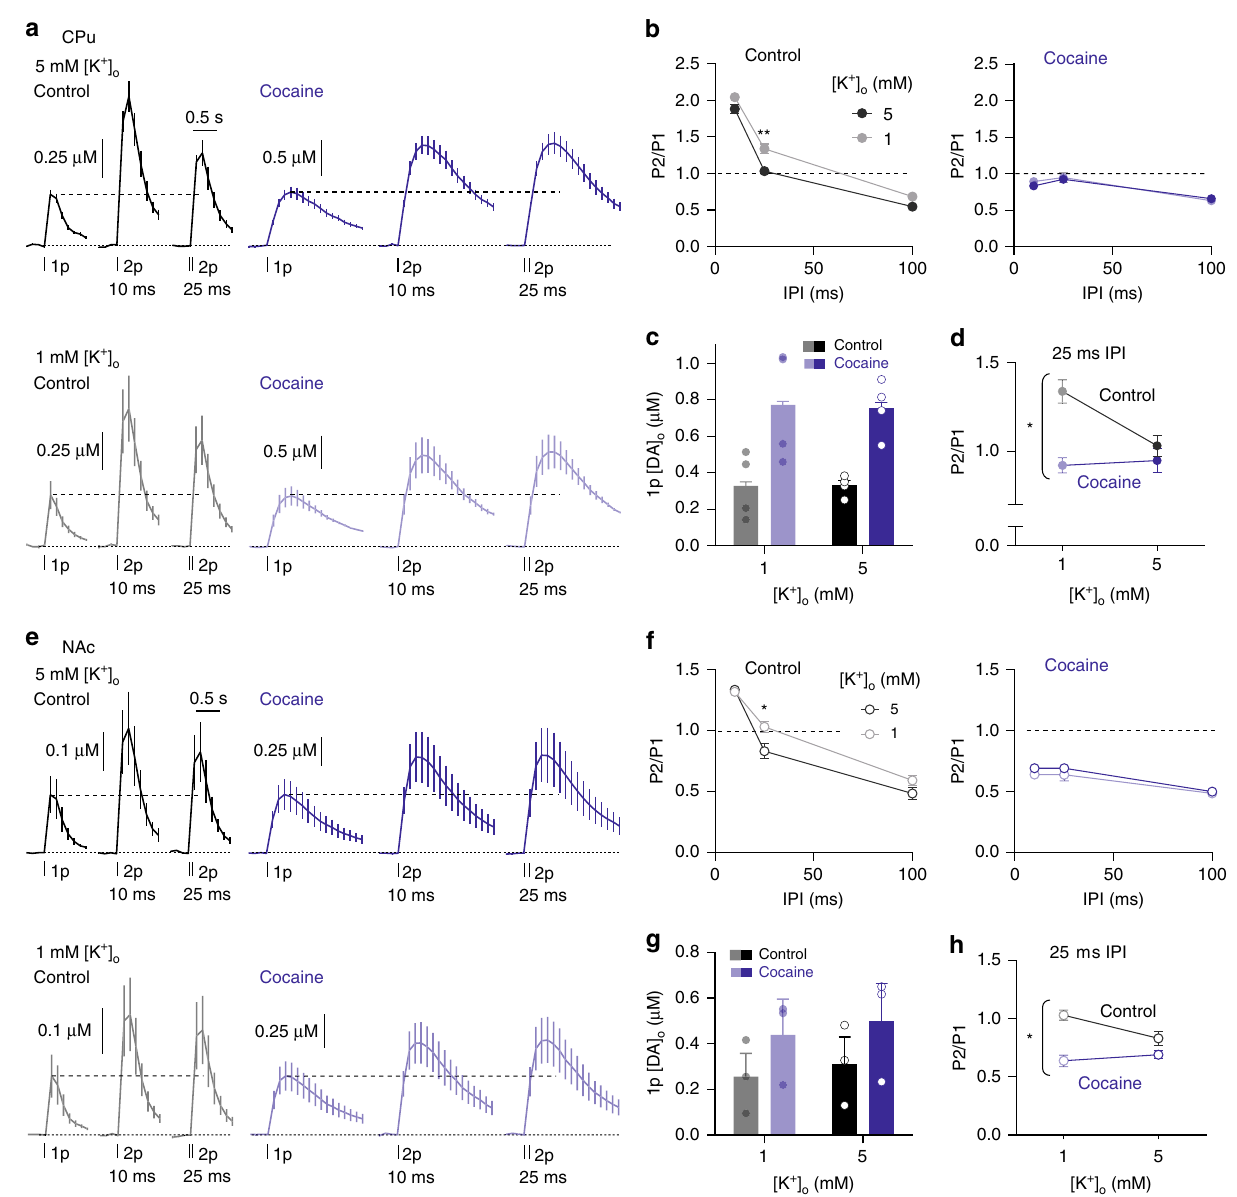
Fig. 8 DATs and [K + ] o gate short-term plasticity through overlapping mechanisms. a , e Mean pro fi les of [DA] o transients elicited by single or paired electrical pulses in control conditions or cocaine in 5 mM [K + ] o (upper) and 1 mM [K + ] o (lower) in CPu ( a , n = 4) and in NAc ( e , n = 3). b , f Mean P2/P1 vs IPI in 5 mM [K + ] o (black) and 1 mM [K + ] o (grey) in control conditions (left) or cocaine (right) in CPu ( b ) and in NAc ( f ). c , g Mean 1p [DA] o in control conditions (black-grey) or cocaine (blue) in CPu ( c ) and in NAc ( g ). d , h Mean P2/P1 in CPu at 25 ms IPI in 1 mM and 5 mM [K + ] o in control conditions or with cocaine in CPu ( d ) and in NAc ( h ). Two-way ANOVA with Bonferroni ’ s test for post hoc comparisons; * P < 0.05, ** P < 0.01. Error bars are ± SEM. Source data are provided as a Source Data fi